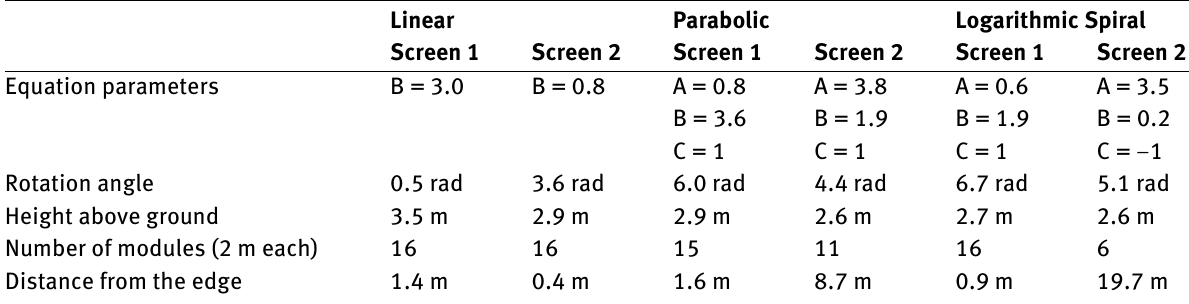
Table 3: Optimum screen configuration for Receiver